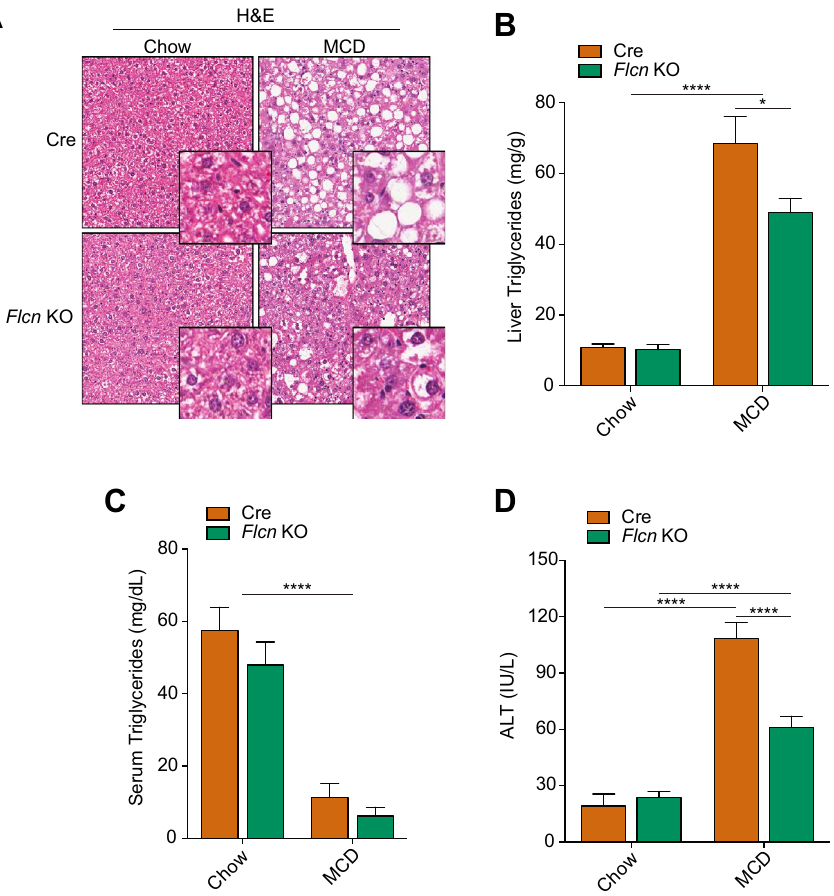
Figure 2. Flcn loss reduces MCD diet-induced liver triglyceride accumulation and liver damage. ( A ) H&E staining in liver sections of mice fed either chow or methionine/choline deficient diet (MCD) over a period of 6 weeks. Images are representative of 8 mice per condition. ( B ) Liver triglycerides quantification in mice fed as described in ( A ) (mean ± SEM, two-way ANOVA, *P < 0.05; **P < 0.01; ****P < 0.0001; n = 8 mice per condition). ( C ) Serum triglycerides quantification in mice fed as described in ( A ) (mean ± SEM, two-way ANOVA, *P < 0.05; ****P < 0.0001; n = 8 mice per condition). ( D ) Alanine transaminase (ALT) quantification in mice fed as described in ( A ) (mean ± SEM, two-way ANOVA, **P < 0.01; ****P < 0.0001; n = 8 mice per